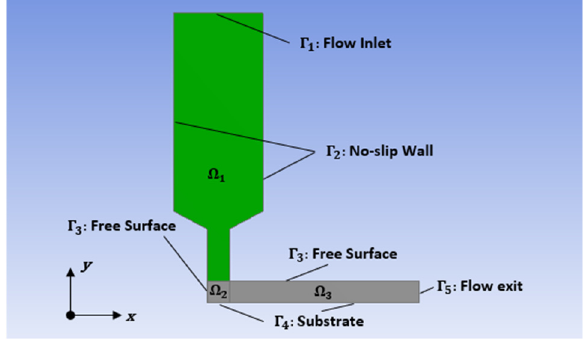
Figure 3. Planar deposition flow domain.